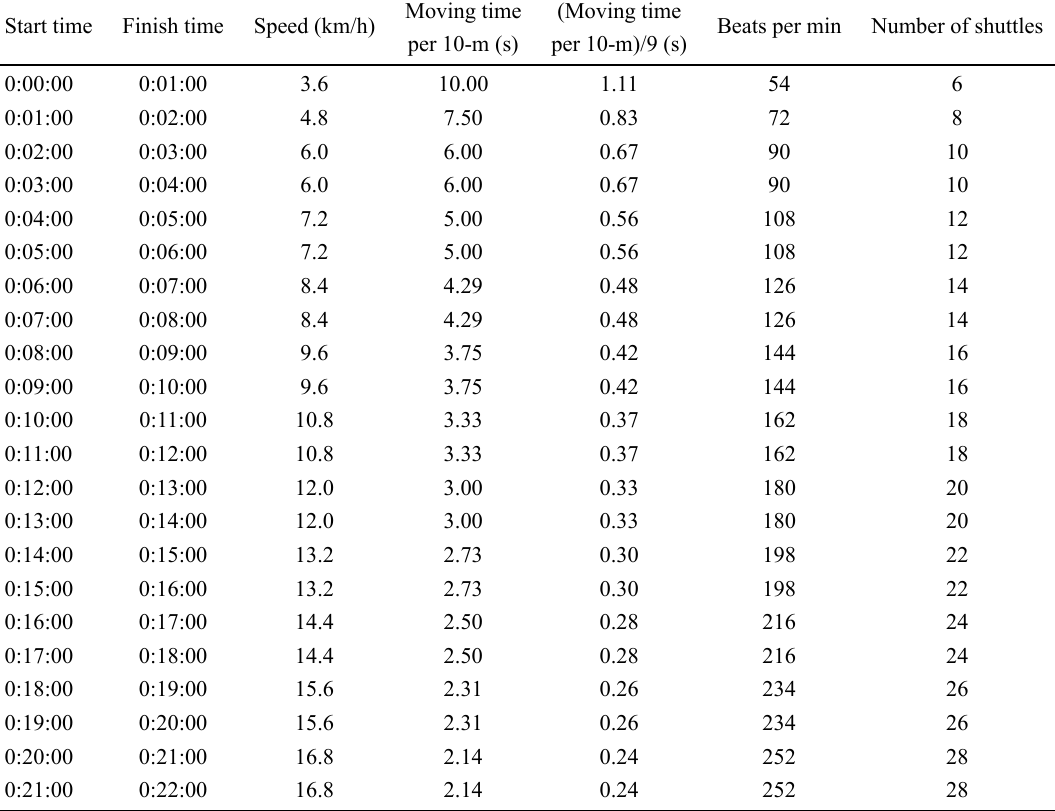
Table 3. Table 3. Protocol of multistage 10-m shuttle run test (converting from speed to beats). Start time